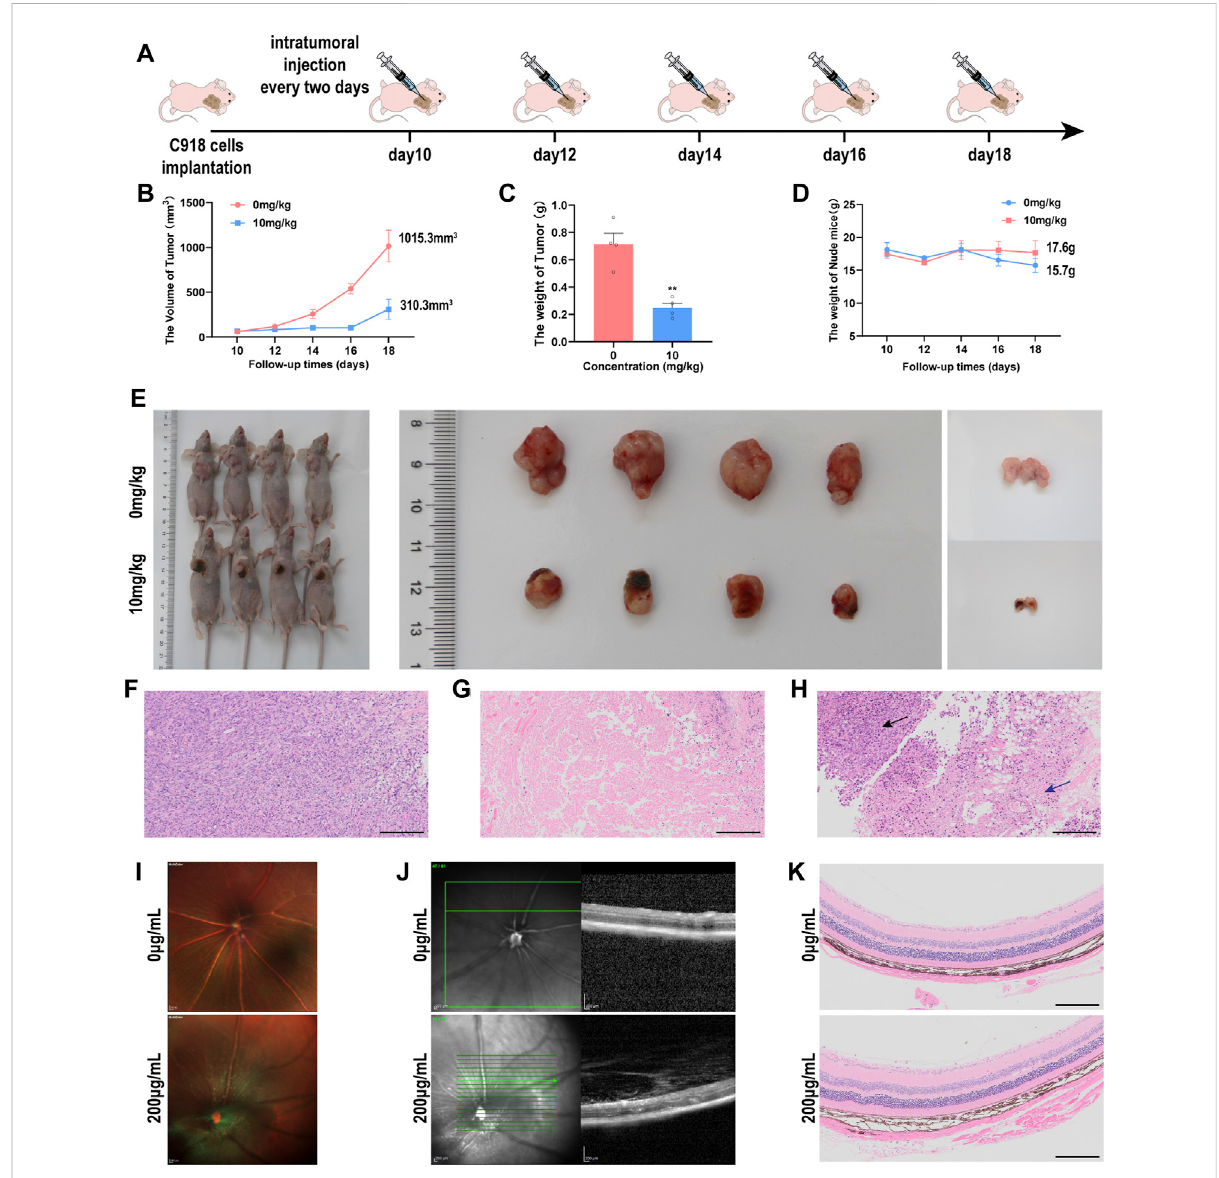
FIGURE 7 The multi-mode imaging in vivo (A) Timeline of the tumor-bearing nude mice experiment. (B) the tumor sizes of the UM tumor-bearing mice duringthetreatment (C) TumorweightsoftheUMtumor-bearingmiceattheendofthetreatment(n=4,** p < 0.005) (D) Thebodyweightsofnude mice bearing UM tumor xenografts during the treatment. (E) Images of the sizes of xenograft UM tumors during NMQDs-Ti 3 C 2 Tx treatment (F) H&E stainingofthetumorsfromcontrolgroup.Scalebar,200 μ m. (G) H&Estainingofthetumorsfromthetherapeuticgroup.Scalebar,200 μ m (H) H&Estainingofthetumorsfromthedemarcationoftherapeuticgroup.Theblackarrowpointstothenormaltumortissue,andthebluearrowpoints to necrosis. Scale bar, 200 μ m. (I) Ocular fundus images of experimental mice. Scale bar: 200 μ m (J) OCT images of the mice retina. Scale bar: 200 μ m. (K) H&E staining of the retina from the mice. Scale bar: 200 μ